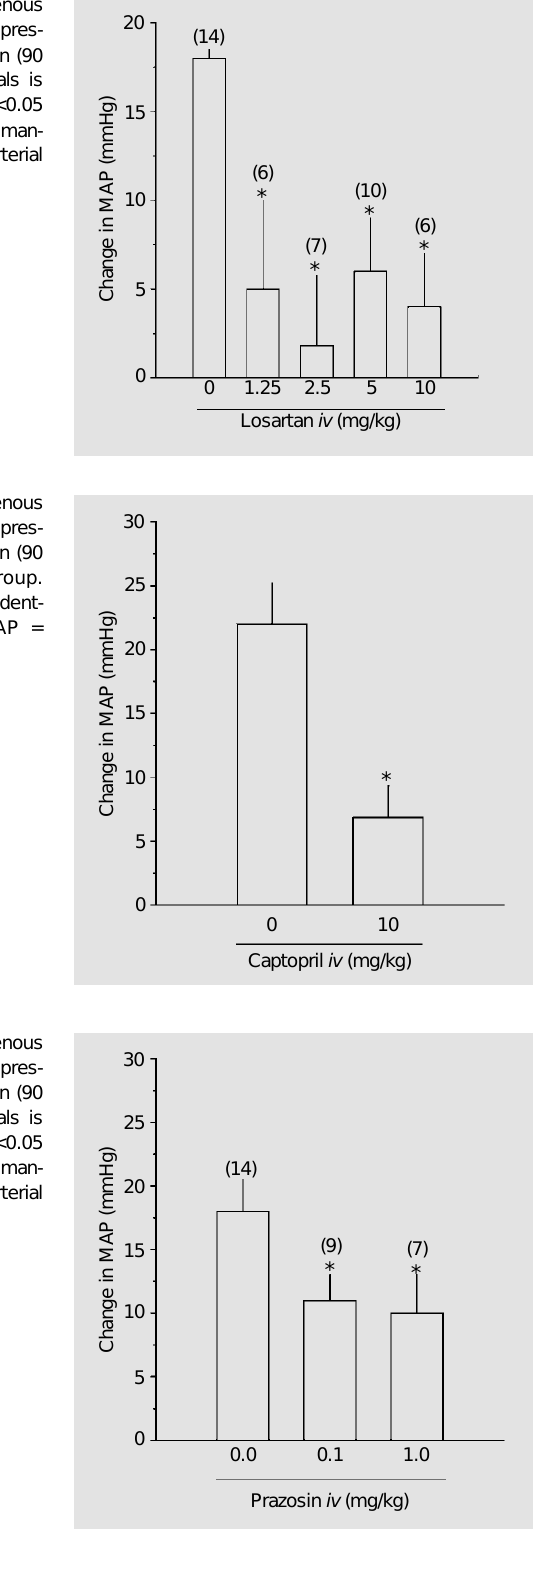
Figure 1. Effect of intravenous injection of losartan on the pres- sor response to icv losartan (90 µg). The number of animals is given in parentheses. *P<0.05 vs doze zero (Student-Newman- Keuls test). MAP = mean arterial pressure.